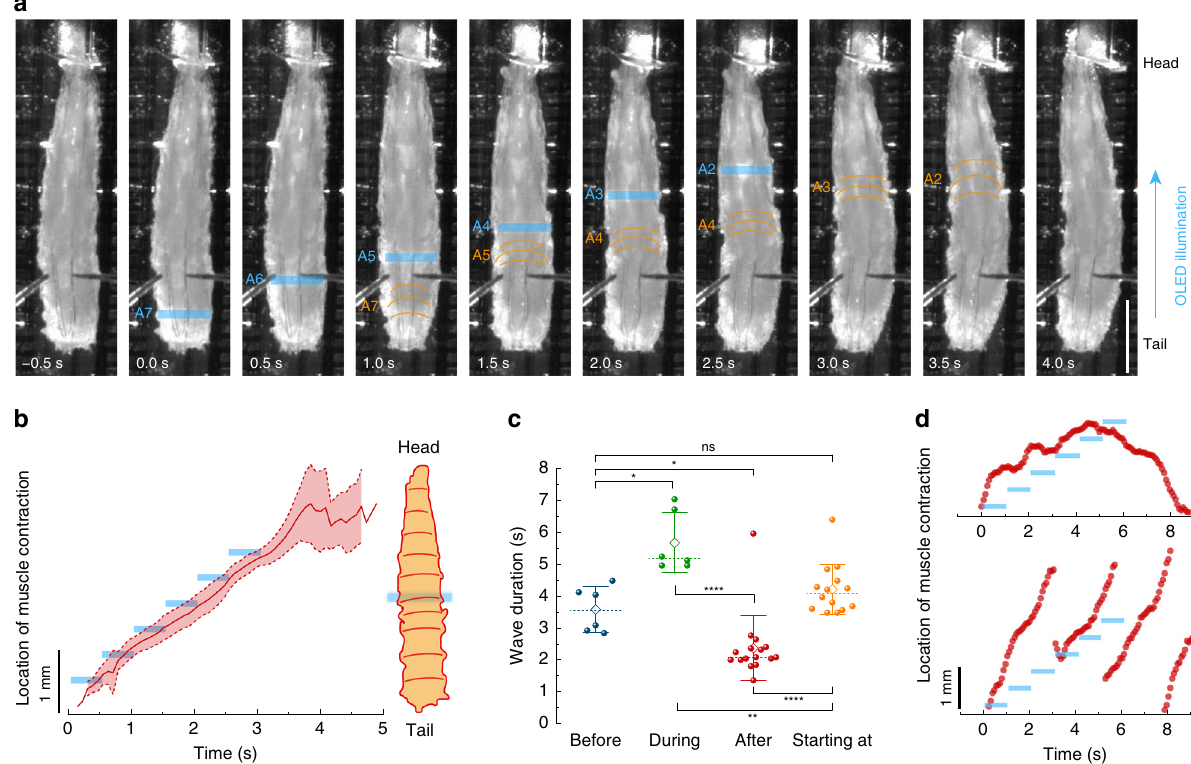
Fig. 7 Response of 5 – 40-GAL4 > CsChrimson larvae to wave-like optical stimulation from posterior to anterior. a Representative time-lapse images. The contracted larval segment is indicated by orange lines in each frame. Active OLED pixels are indicated in blue. Scale bar: 1 mm. See Supplementary Movie 6 for complete time lapse. b Overlay traces showing mean ± SD of the location of muscle contraction waves over time. The timing and location of the active OLED pixel are indicated by blue bars. n = 3 larvae, nine stimulations. c Wave durations grouped by start and end time of the wave relative to the optical stimulation. Before: wave ended before optical illumination. During: wave started before illumination and ended after illumination ceased. After: wave started after illumination. Starting at: wave started during illumination. n = 4 larvae. Two-tailed t test: n.s. not signi fi cant ( P > 0.05), * P < 0.05, ** P < 0.01, **** P < 0.0001. Whiskers: SD; diamond: mean; dashed line: median. d Two representative traces showing the location of muscle contraction in response to slowed-down wave-like stimulation. Light intensity: 30 µ W mm − 2